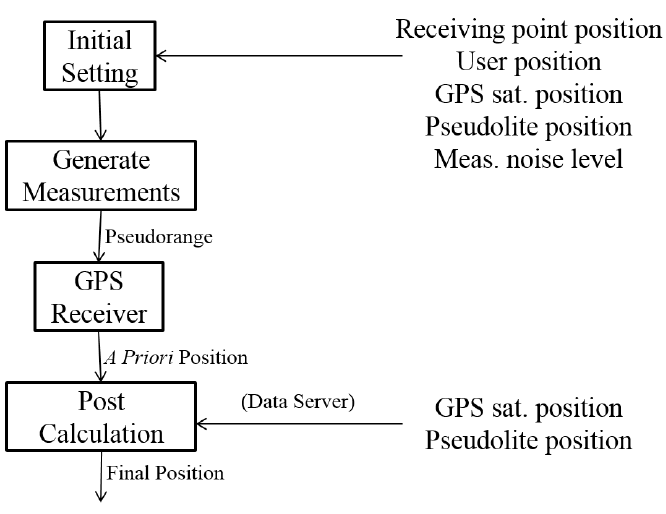
Figure 9. Simulation